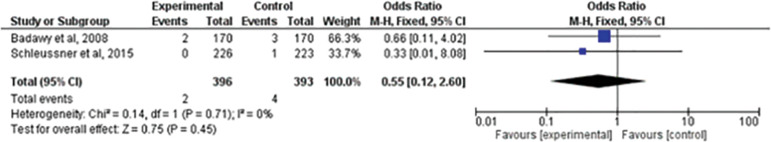
Forest-plot of placental premature detachment incidence with treatment